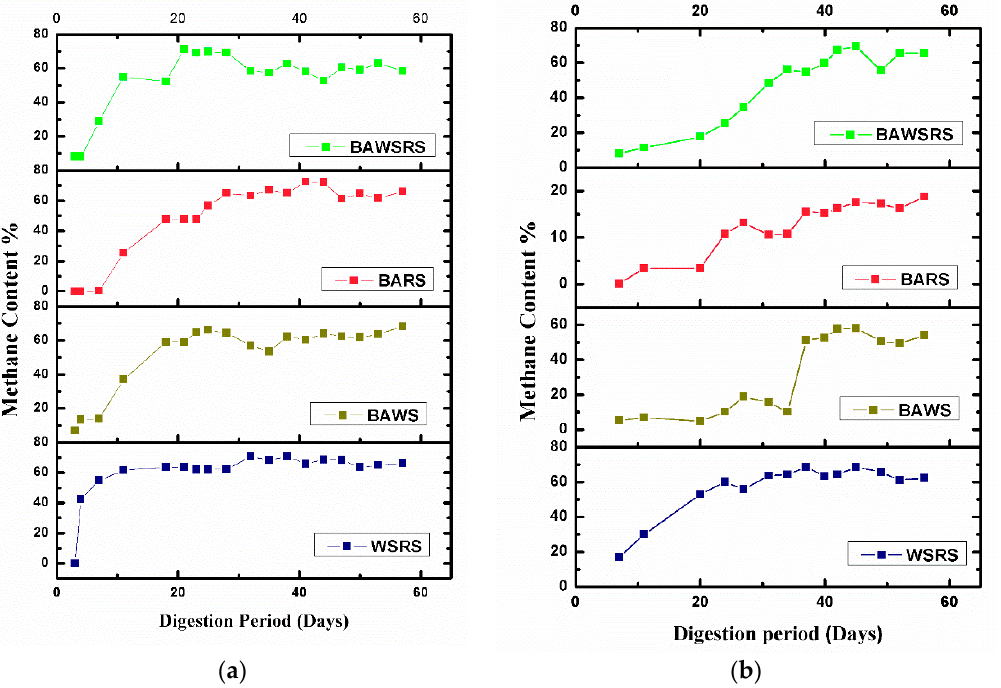
Figure 2. Methane % Potential of Reactors with (S/I ratio) ( a ) 1.5 and ( b ) 2.5. This suggests that an increase in substrate concentration would lower the hydrolysis rate and methane production. After the startup phase, the maximum methane production recorded by reactors WSRS, BAWS, BARS, and BAWSRS (Experiment 1; S/I ratio 1.5) was 70.63%, 64.5%, 65%, 69%, respectively. Similarly, maximum methane production for reactors WSRS, BAWS, BAWSRS, and BARS (Experiment 2; S/I ratio 2.5) was recorded as 68.5%, 58%, 65.5%, and 18%, respectively. Furthermore, the graph of cumulative methane yield is shown in Figure 3a,b for both Experiments. The maximum methane yield observed for all reactors WSRS, BAWS, BARS, and BAWSRS of Experiment 1 were 393.08 NmLCH4/gVS, 177.96 NmLCH4/gVS, 188.299 NmLCH4/gVS, and 337.900 NmLCH4/gVS, respectively. Whereas, for Experiment 2, methane yield of reactors WSRS, BAWS, BARS, and BAWSRS were 244.78 NmLCH4/gVS, 65.79 NmLCH4/gVS, 15.74 NmLCH4/gVS, and 151.34 NmLCH4/gVS, respectively. Among both experiments, the combinations in Experiment 2 show an initial lag in methane production, the inhibition is likely due to higher lignin content and an increase in organic loading ratio (increase in the substrate concentration) [36]. Lignin has a recalcitrant structure that limits the degradation of lignocellulosic waste whereas cellulose and hemicellulose degrade after the hydrolysis process, the degradation of cellulose and hemicellulose in lignocellulosic material would govern me- thane production [37,38]. Moreover, the substrates used in the present study show bagasse has higher lignin content and lower methane production. Lignin is the protective barrier that provides support to the lignocellulosic structure and resists any microbial attack and oxidative stress. Additionally, lignin is insoluble in water hence, anaerobic bacteria re- quire more time to adhere on the substrate to start the anaerobic digestion. In the compar- ison of both experiments’ reactor WSRS yields higher methane due to lower lag phase and lignin content, methanogenic bacteria degraded the lignin faster as compared to other re- actors. Additionally, mechanical pretreatment given to all substrates increases surface ac- cessible area, decreases crystallinity, and surface polymerization to enhance biodegrada- bility; these are the factors that fasten the hydrolysis rate [39]. Production of biomethane is correlated with the degradation or digestibility of organic matter by anaerobic microor- ganisms. VS reduction is the amount of VS degraded by the bacteria; higher degradation leads to more VS reduction, which ultimately results in excessive biogas production [40].